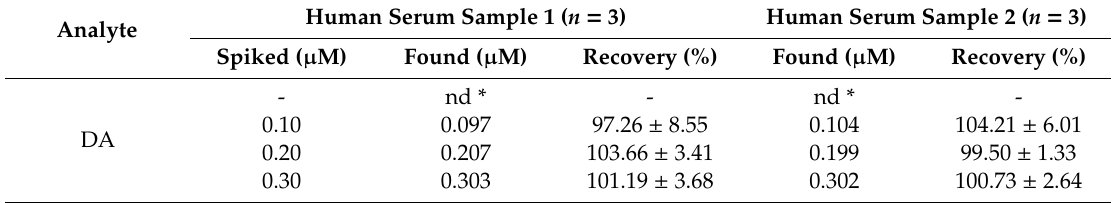
Table 2. The recovery of the proposed supramolecular electrochemical sensor for the detection of DA. Human Serum Sample 1 ( n = 3) Human Serum Sample 2 ( n = 3) Analyte Spiked ( µ M) Found ( µ M) Recovery (%) Found ( µ M) Recovery (%) - nd * - nd * - 0.10 0.097 97.26 ± 8.55 0.104 104.21 ± 6.01 DA 0.20 0.207 103.66 ± 3.41 0.199 99.50 ± 1.33 0.30 0.303 101.19 ± 3.68 0.302 100.73 ± 2.64 * nd: not